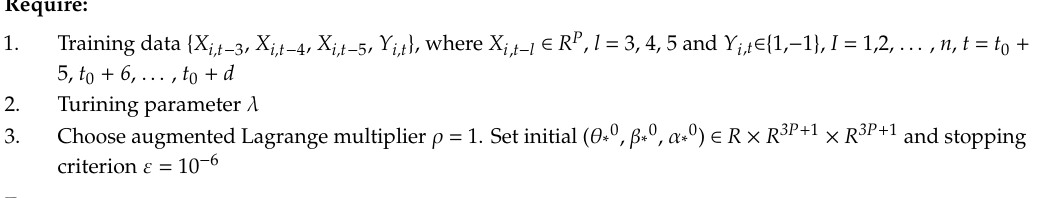
Algorithm 2. A finite Armijo–Newton algorithm for the sub-problem (19a). 1 : δ is the parameter associated with finite Armijo Newton algorithm and between 0 and 1.